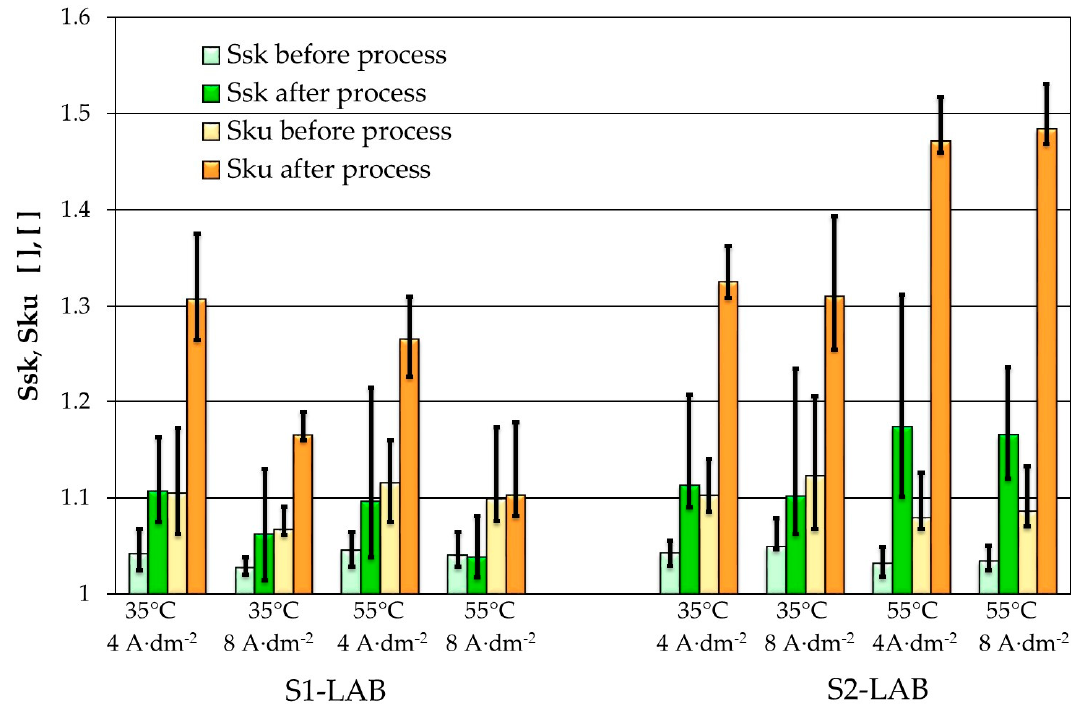
Figure 6. S sk and S ku parameters of samples surfaces before and after electropolishing in various parameters of temperature and current density.